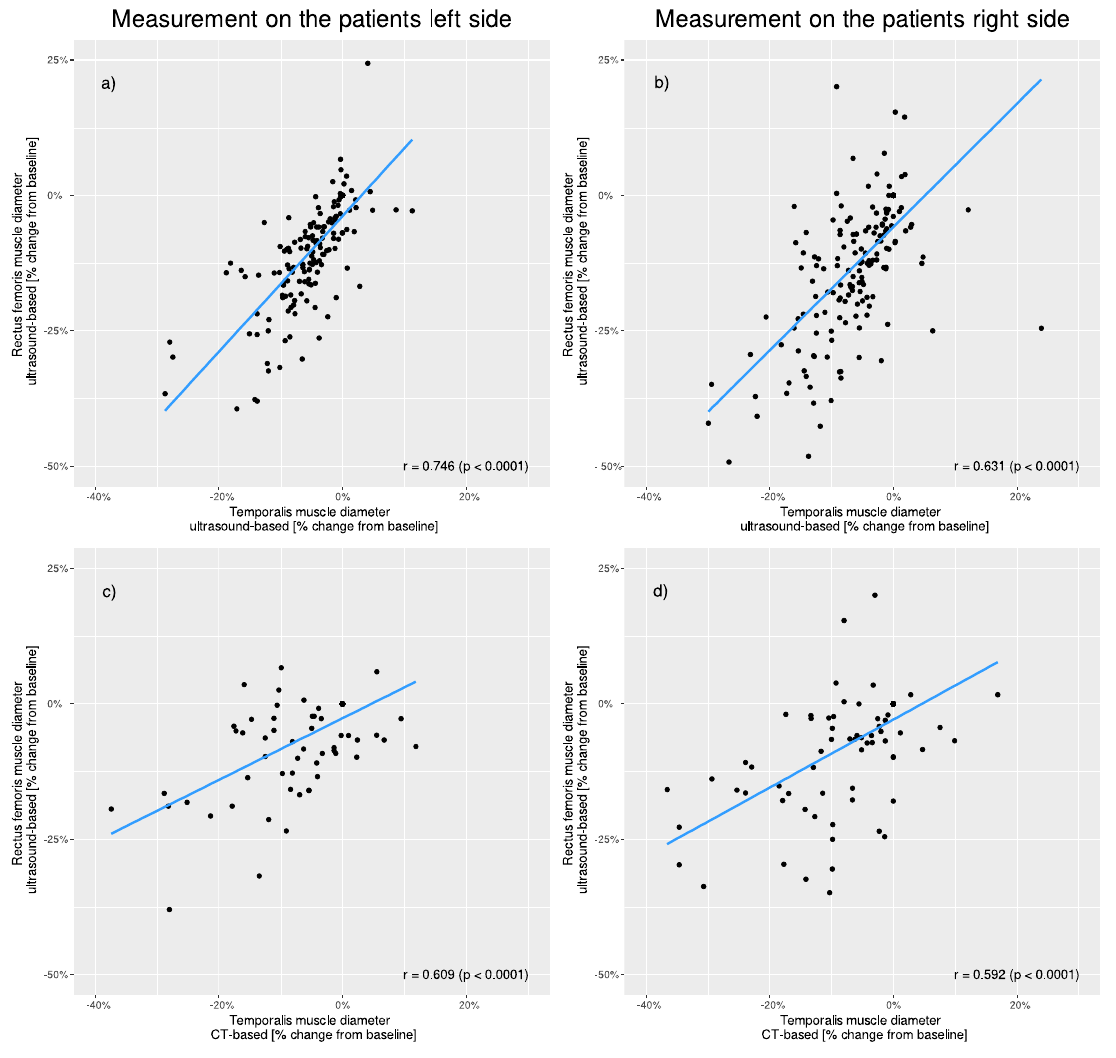
Figure 4. Correlation of percentage changes in muscle thickness between different muscle groups and different measurement techniques. Comparison of the patients’ ( a ) left and ( b ) right-sided ultrasound- based rectus measurements to ultrasound-based temporalis measurements. Comparison of the patients’ ( c ) left and ( d ) right-sided ultrasound-based rectus measurements to CT-based temporalis